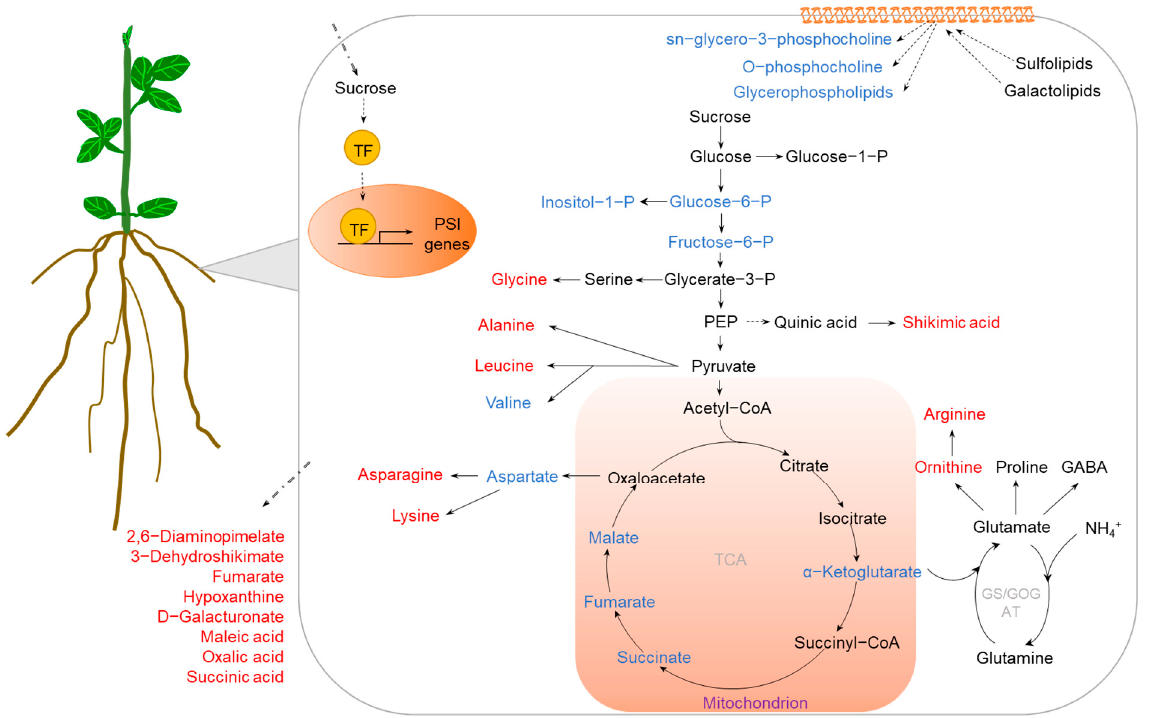
Figure 2. Metabolic pathways regulated by P deficiency in crop roots. The specific changes in metabolites involve organic acids and phospholipids, which may be related to external Pi acquisition and internal P reutilization, respectively. The accumulated and reduced metabolites are marked in red and blue, respectively. Abbreviations: PSI (phosphate starvation-induced), P (phosphate), PEP (phosphoenolpyruvic acid), GABA ( γ -aminobutyric acid), TCA (tricarboxylic acid), GS/GOGAT (glutamine synthetase/glutamate synthetase).